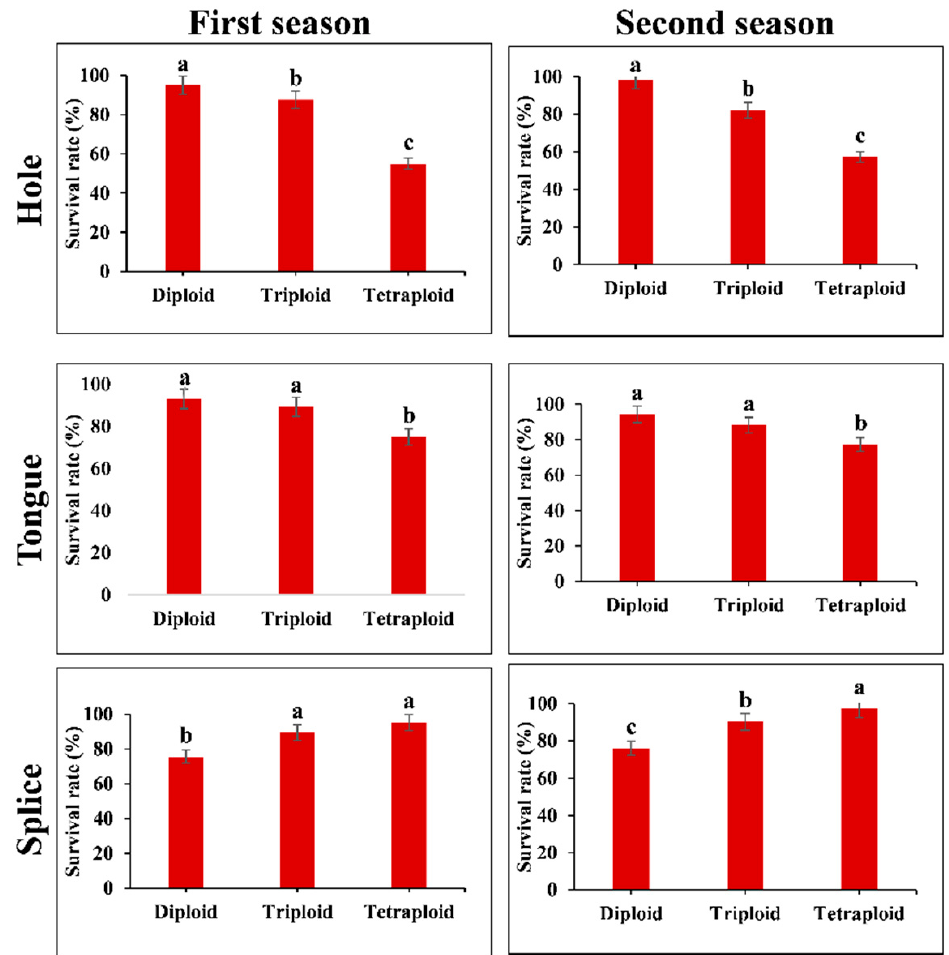
Figure 2. The survival rate of different grafting methods among different ploidy watermelon at 15 days after grafting during March and August 2019 cropping seasons. The bars with different letters differ significantly ( p < 0.05).